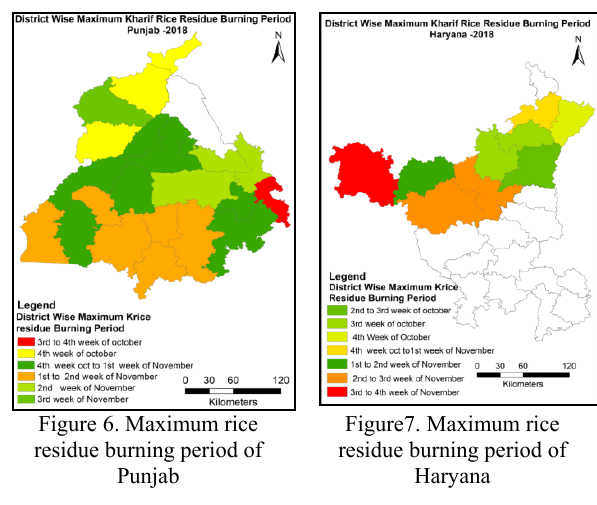
Figure 9. District wise fire counts percentage in Haryana